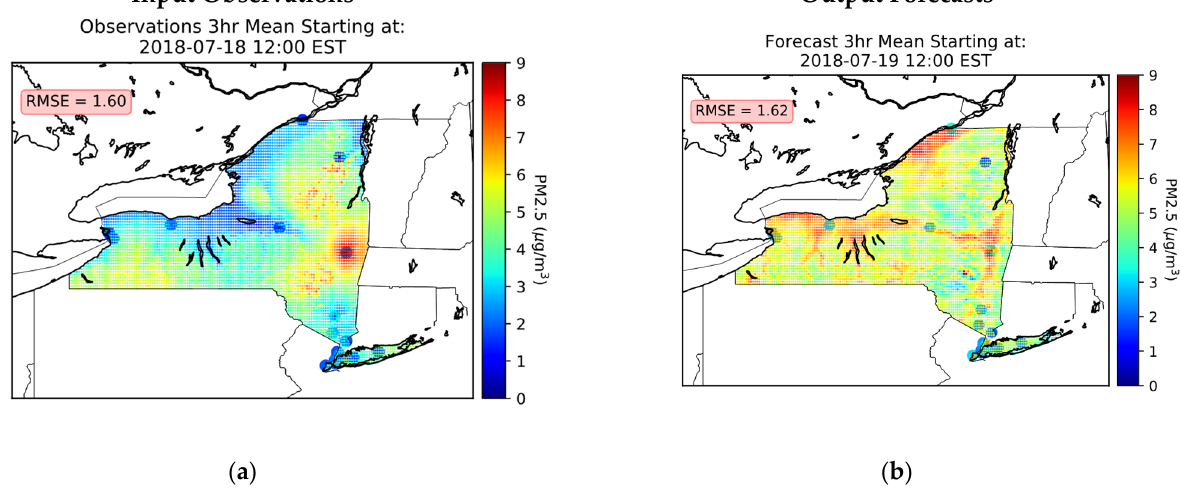
Figure 11. To demonstrate the ability of the DNN to forecast change, not just react to it, we highlight a case where the spatial patters of PM 2.5 concentrations are significantly different in the observation time window compared to the next day forecast: ( a ) input observations; ( b ) output forecast. The RMSE value in each plot indicates the regression score for the accuracy of the forecast at that particular time.